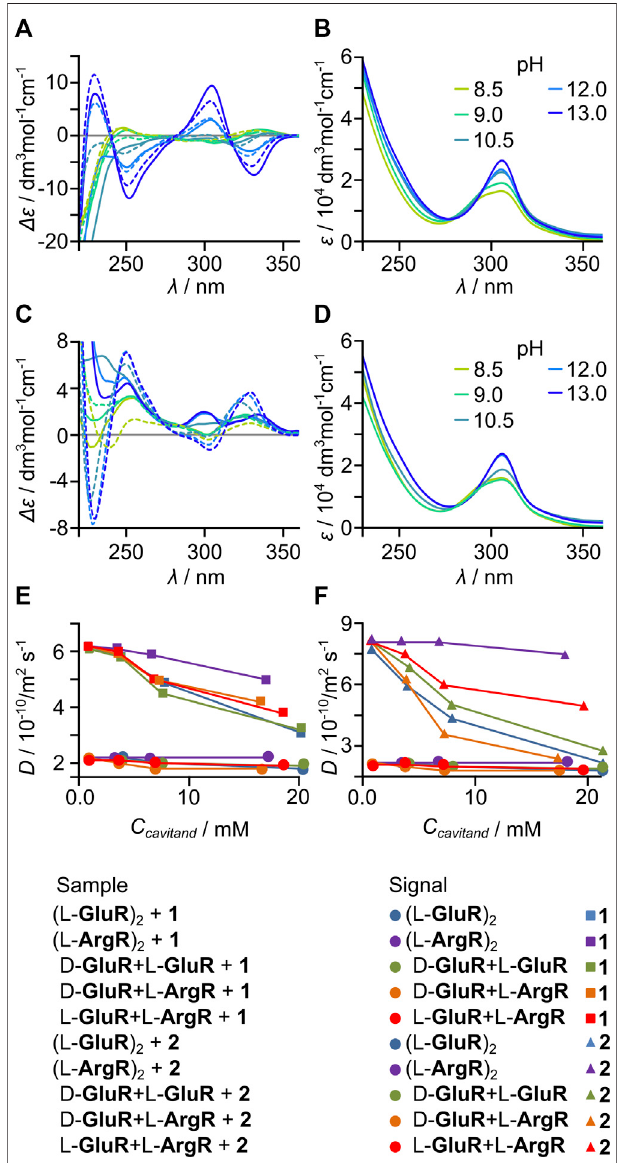
FIGURE4| Formationofheterodimers: (A) pH-dependentECD,and (B) UV spectra of D- GluR + L- ArgR ; (C) pH-dependent ECD and (D) UV spectra of L- GluR + L- ArgR (solid lines — experimental spectra and dashed lines — a weighted mathematical sum of the components at given pH). Diffusion coef fi cientchanges(capsules ’ andguests ’ signals)duringtitrationof (E)1 and (F) 2 , with various capsules (pH = 9, C (guest) = 10 mM).